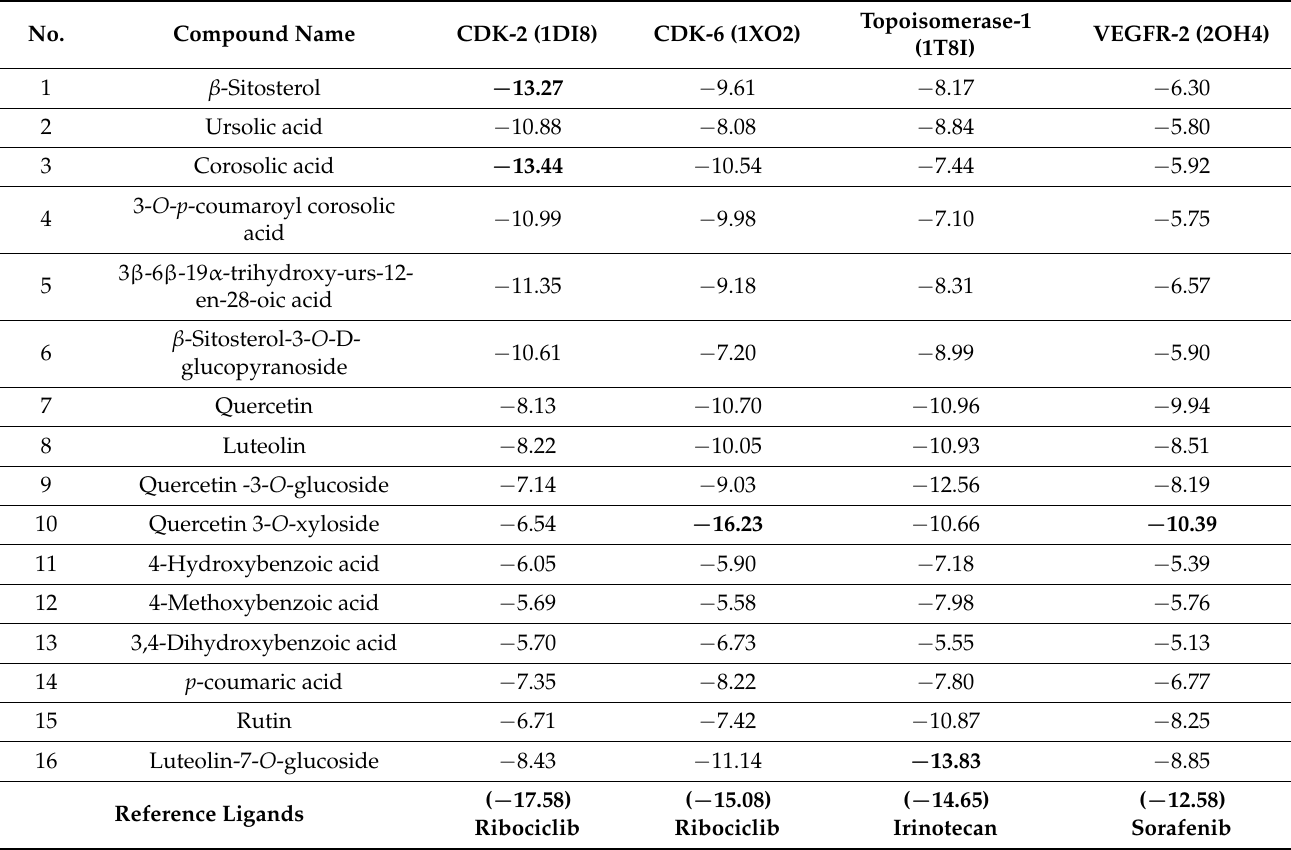
Table 2. The binding energies of the secondary metabolites docked with the four target